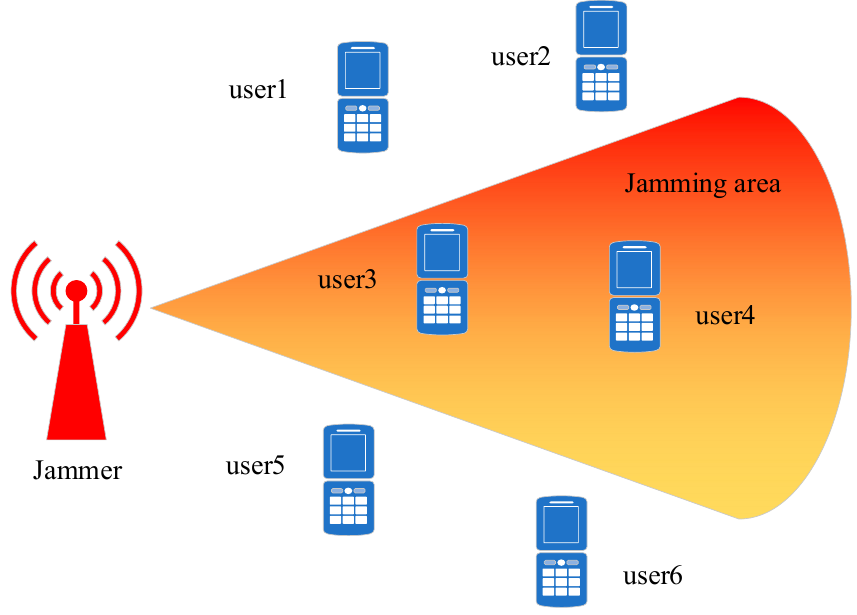
Figure 1. Schematic diagram of system model.